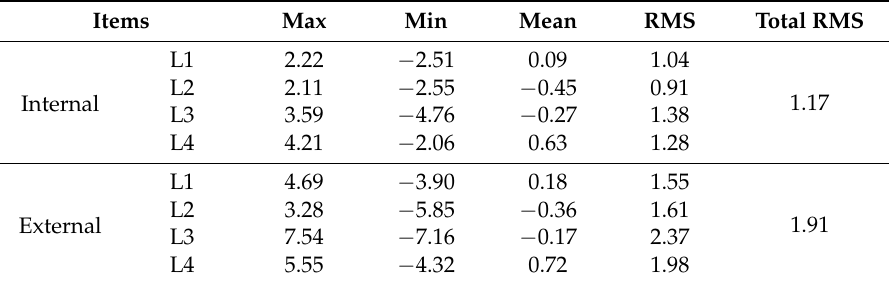
Table 3. Statistics of differences for internal and external consistency (Units: